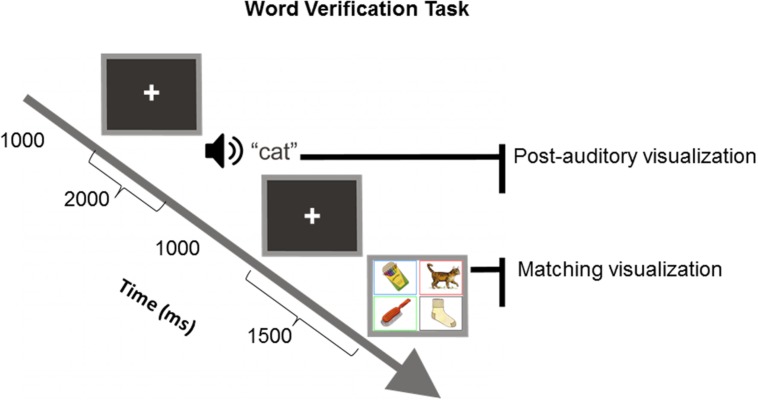
Representation of the word verification task (WVT) used in the present experiment, indicating stimulus timing for the auditory and visual parts of the task. The interval for the auditory and visual averages was -200 to 1000 ms around stimulus onset followed by a correct response to the visual stimulus. The visual presentation remained on the screen until the participant made a response. The length of the post-response cross fix allowed the researcher to re-iterate the experiment requirements to the participant (e.g., “try not to blink, remain still,” etc.) if necessary.